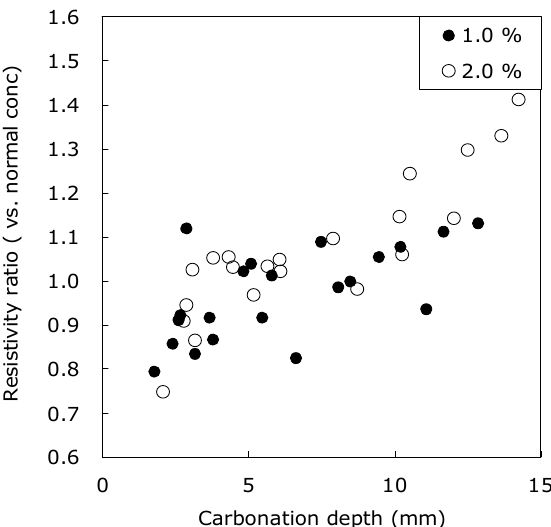
Figure 15. Ratio of the electrical resistivity of carbonated concrete with chloride of 1.0~2.0% and the electrical resistivity of non-carbonated concrete without chloride.